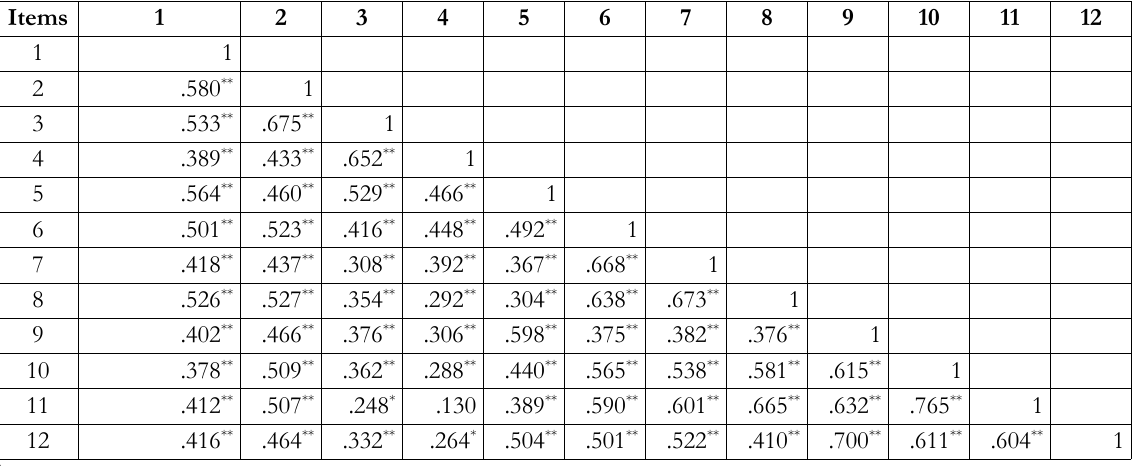
Table 3. Bivariate Pearson correlations of the items on the questionnaire regarding the perception of